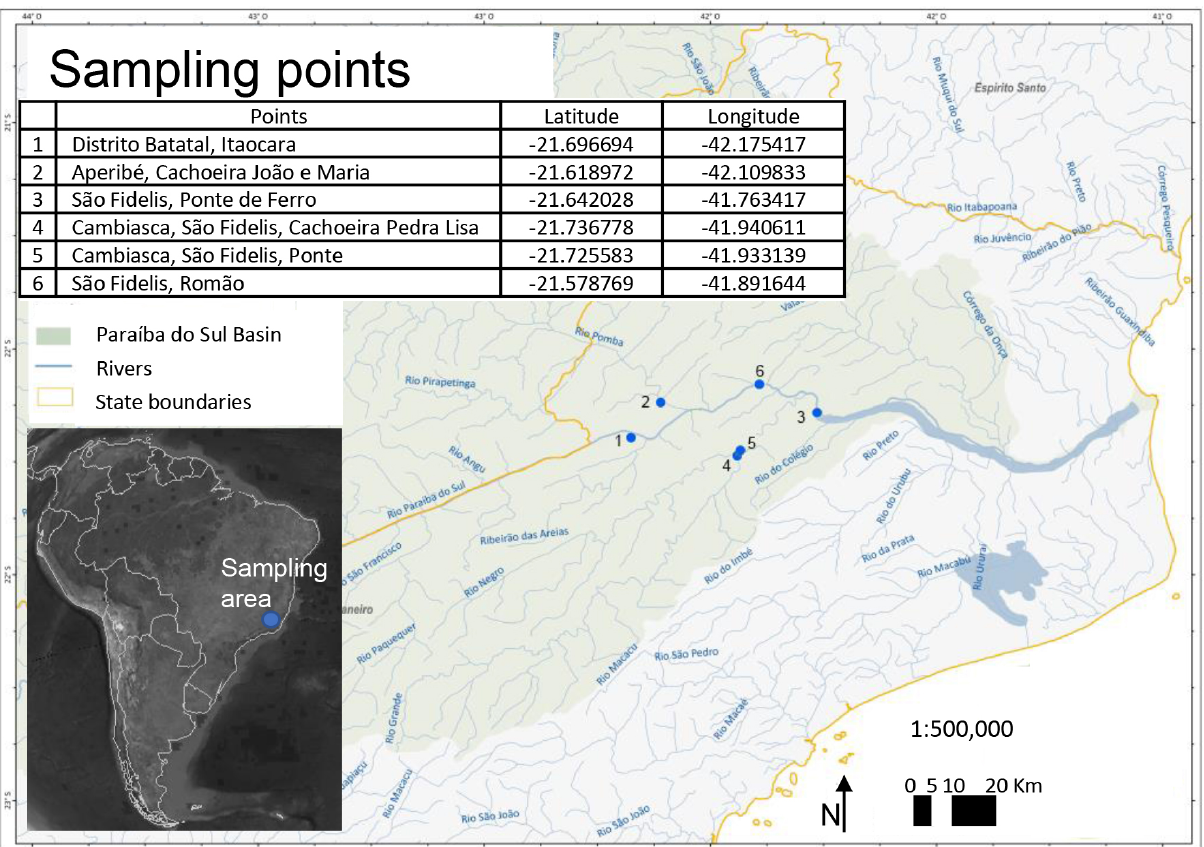
Figure 1. Sampling sites for shrimp of the genus Atya Leach, 1816 in the Fluvial Island Domain in the Paraíba do Sul River basin (modified from Carvalho-Batista et al. , 2019). NOTE: Crustacean sampling sites/Paraíba do Sul River Basin/Main Hydrography/ State